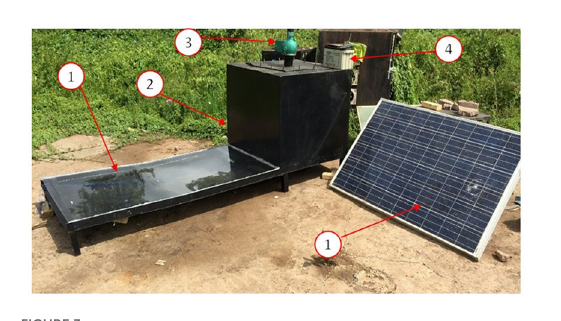
FIGURE3 CFD-based designed and constructed solar dryer for curing of onion bulbs: (1) collector, (2) drying chamber; (3) fan; (4) solar battery, and (5) solar